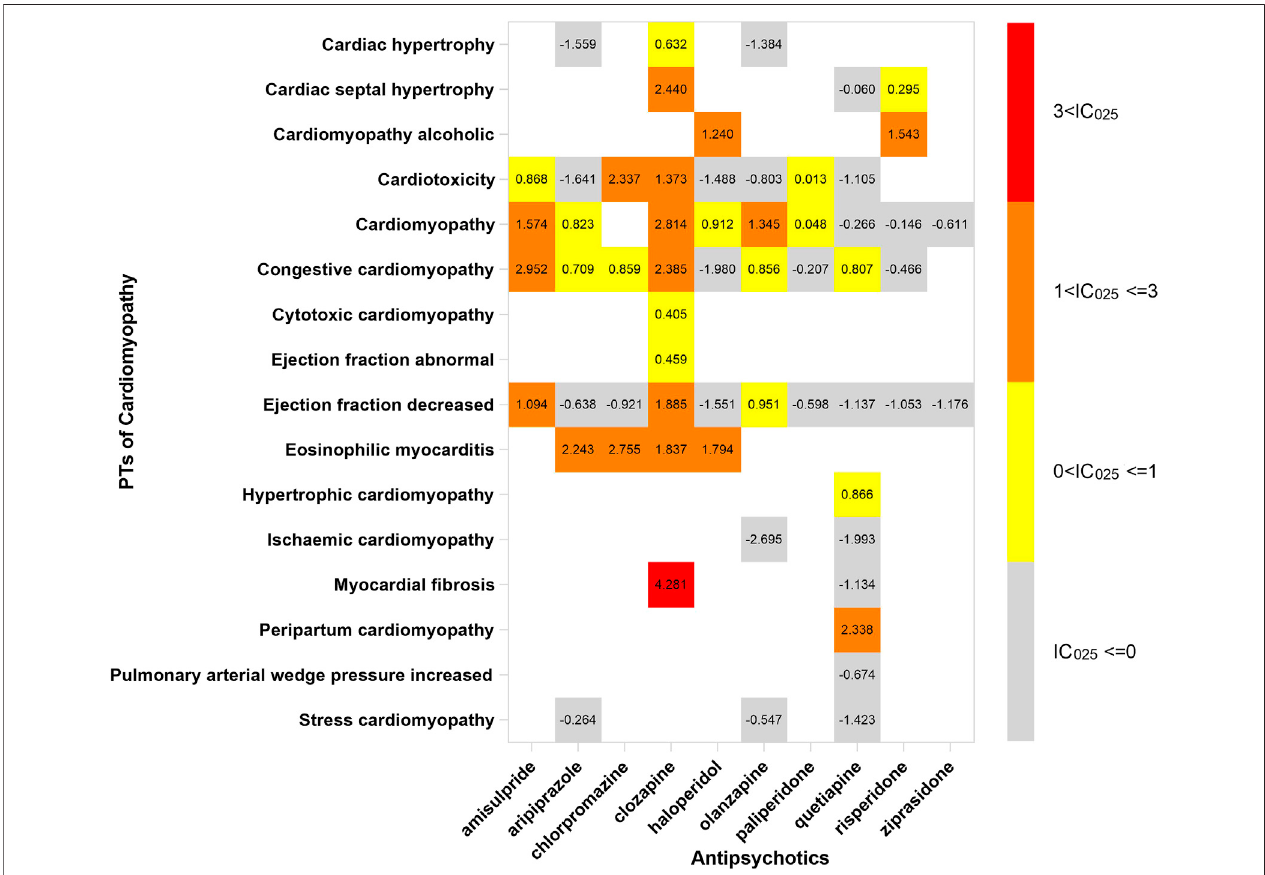
FIGURE 4 | The spectrum of cardiomyopathy induced by various APs. PT: preferred term; IC025: the lower end of the 95% con fi dence interval of the information component.The numbers in blocks represent the valueofIC025 ofeach combinationoftarget antipsychotic and PT.Theejectionfraction decreased isthecommon PT both in cardiac failure and in